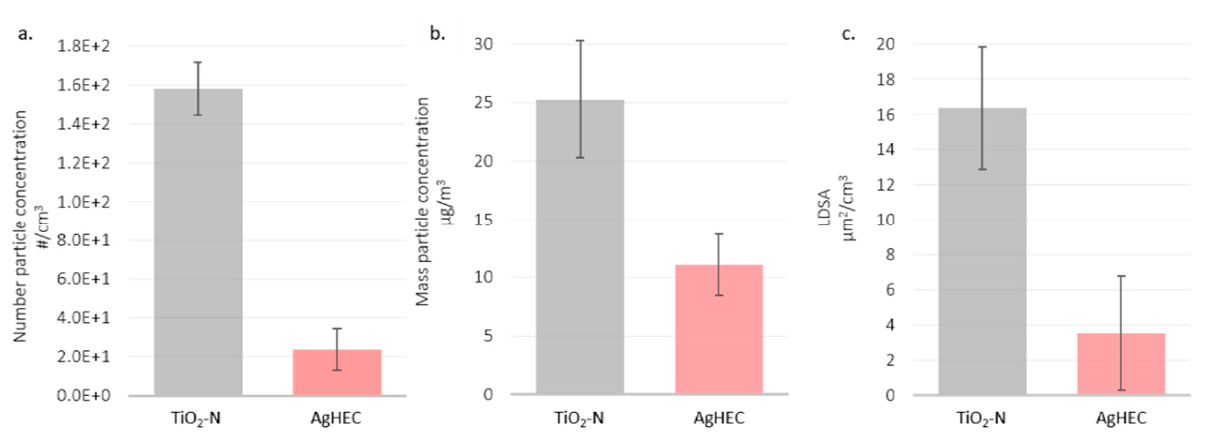
( c ) LDSA values in the particle size range 0.03–0.4 µm. TiO 2 -N in grey, AgHEC in pink.